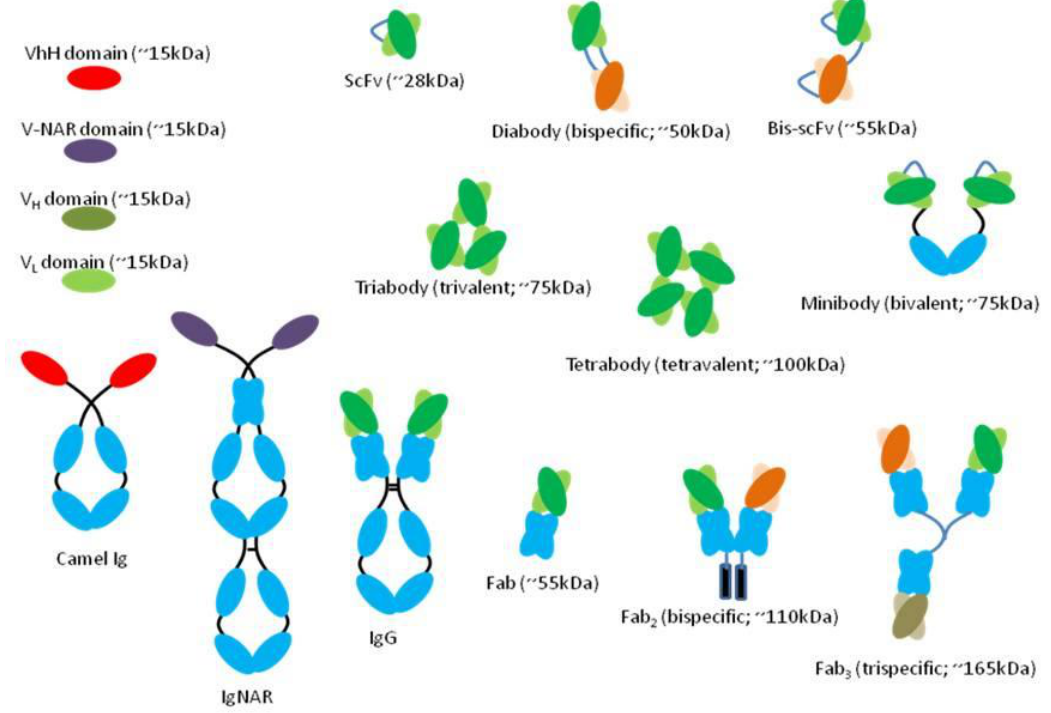
Figure 6. Schematic representation of various antibody formats, including the intact IgG molecule alongside various representations of antibody fragments. Figure from Holliger and Hudson